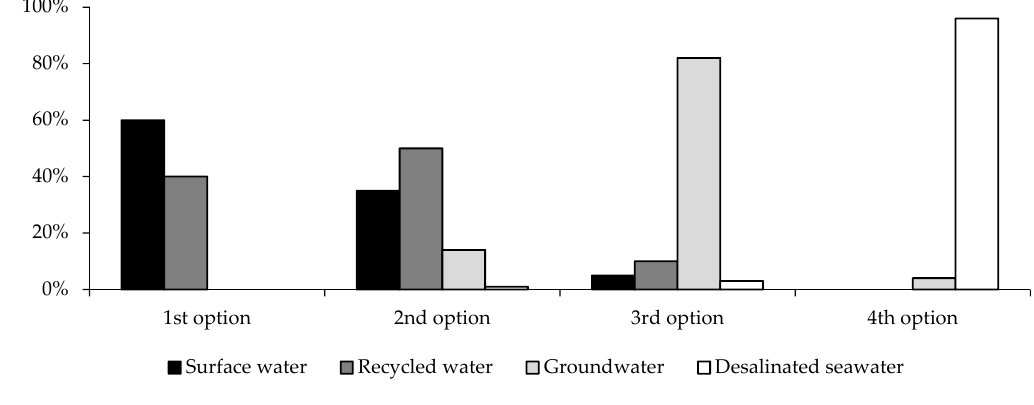
Figure 2. Order of water supply options regardless of price.